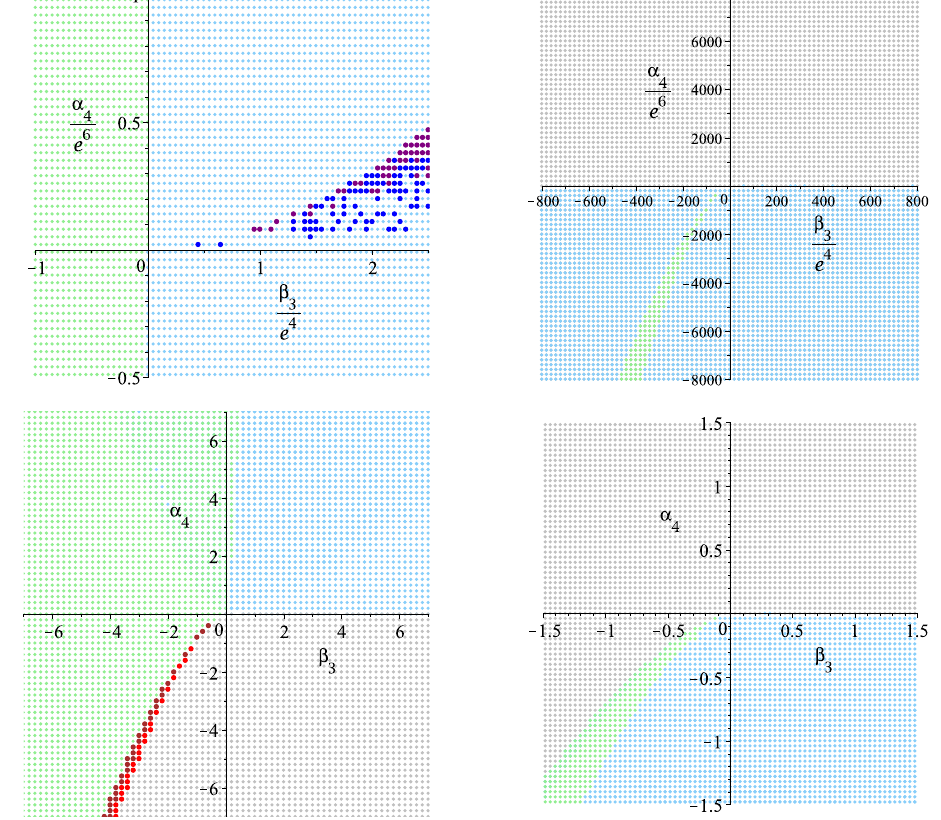
Figure 3 . Number of critical points as a function of the GQG couplings in d = 4 (colour online). Top Left : the number of critical points for (cid:12)xed electric charge ( e = 1) as a function of (cid:11) 4 and (cid:12) 3 for k = 1. The physically admissible region, shown in green colour, has only a single physical critical point for each value of the coupling. For (cid:13) 2 < 0 there are either one (blue), two (dark blue) or three (purple) critical points for a given value of (cid:12) 3 and (cid:11) 4 . Top right : the analogous plot for d = 4 and k = (cid:0) 1 but with e 2 = 0 : 1. Grey regions have no critical points. Bottom Left : the plot for d = 4 and k = 1 but with zero charge. Red and brown regions exhibit two and single critical points with negative entropy. Bottom Right : the critical regions for d = 4 and k = (cid:0) 1 for chargeless case.